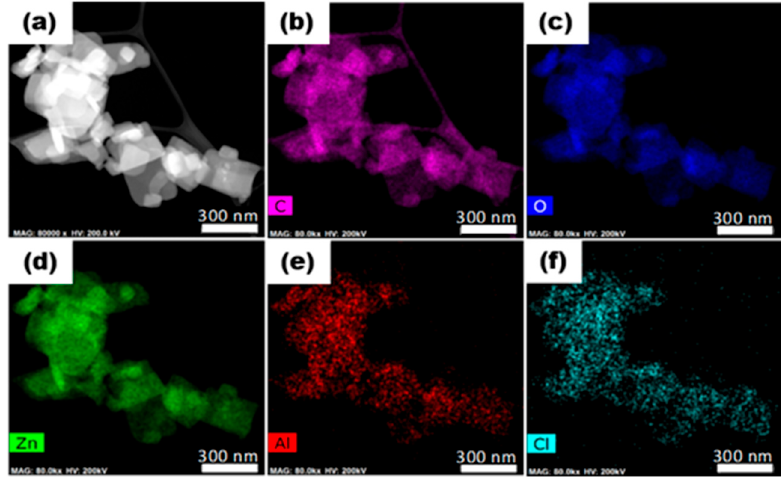
Figure 2. STEM image and EDS mapping. ( a ) STEM image of ZnGA-Al-10 − 3 ; STEM-EDS mapping of ( b ) C (purple), ( c ) O (blue), ( d ) Zn (green), ( e ) Al (red), and ( f ) Cl (cyan) elements in ZnGA-Al-10 − 3 ; (Scale bar: = 300 nm).